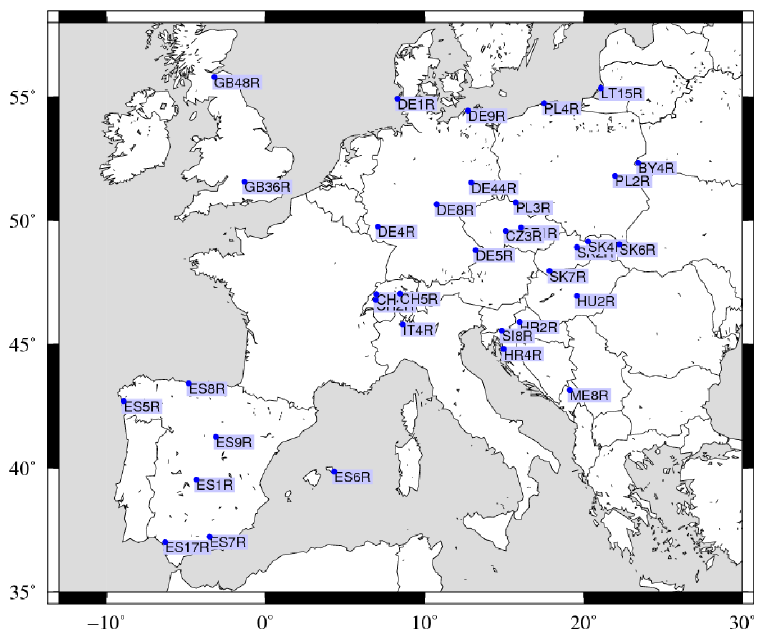
Figure A2. Maps of EMEP sites for the PM 2 . 5 and calcium